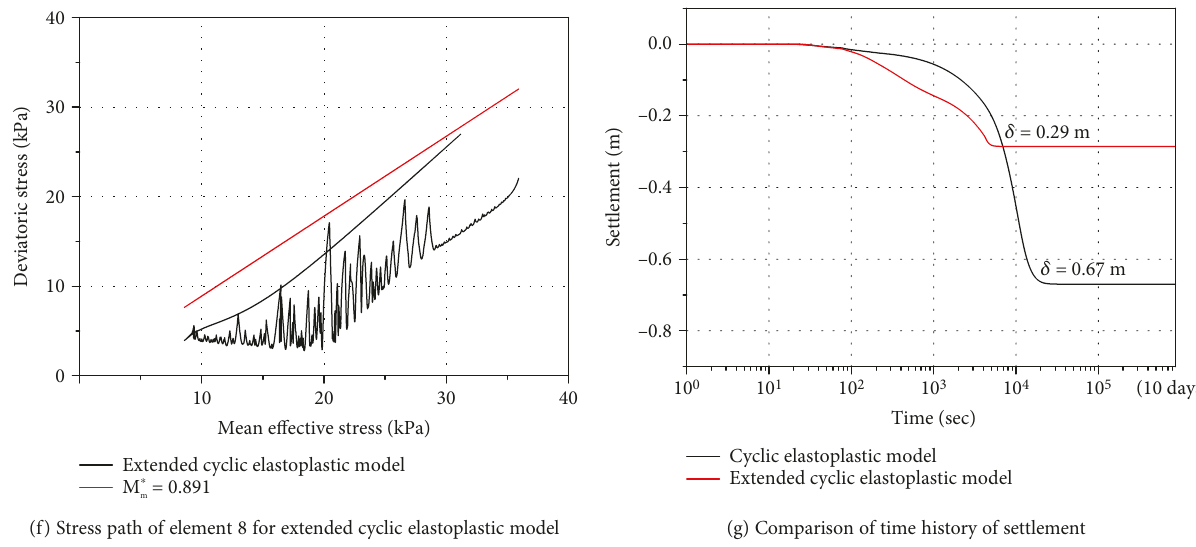
Figure 7: Comparison between the original elastoplastic model and the modi fi ed elastoplastic model.